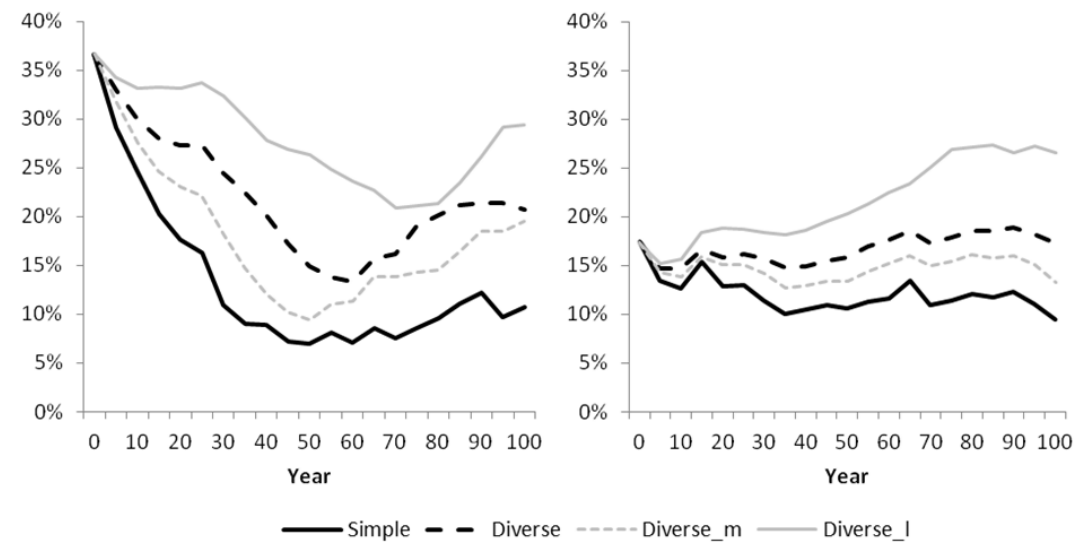
Figure 11. Proportion of sparse forest in Hässleholm ( left ) and Vilhelmina ( right ) for the Simple and Diverse scenarios, as well as the more intensive (Diverse_m) and less intensive (Diverse_l) variations of the Diverse scenario. Sparse forest was defined as forest with less than 1000 stems per ha and a mean stand height of more than 10 m.